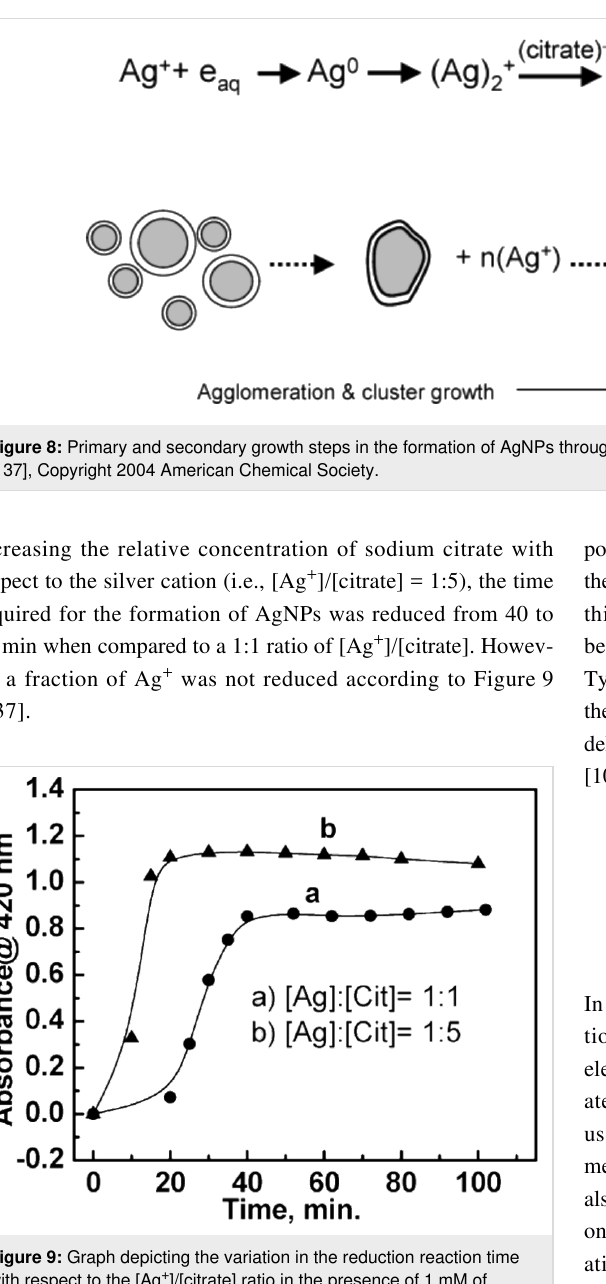
Figure 9: Graph depicting the variation in the reduction reaction time with respect to the [Ag + ]/[citrate] ratio in the presence of 1 mM of AgNO 3 and either (a) 1 mM or (b) 5 mM of sodium citrate as the reducer. Reprinted with permission from [137], Copyright 2004 Amer- ican Chemical